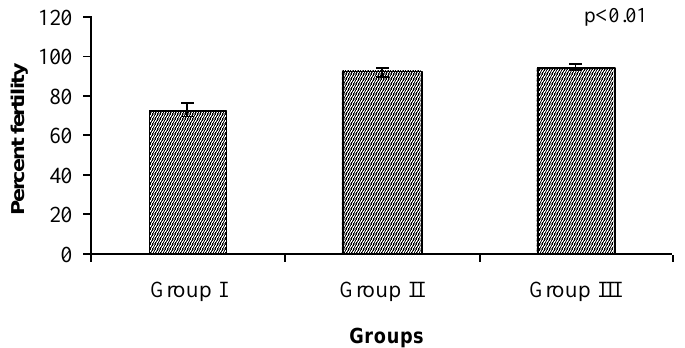
Figure 1. The effect of different doses of dietary L-ascorbic acid (L-AA) supplementation on fertility percentage in laying Japanese quail under low ambient temperature (10.47  C) (mean  SE; N =